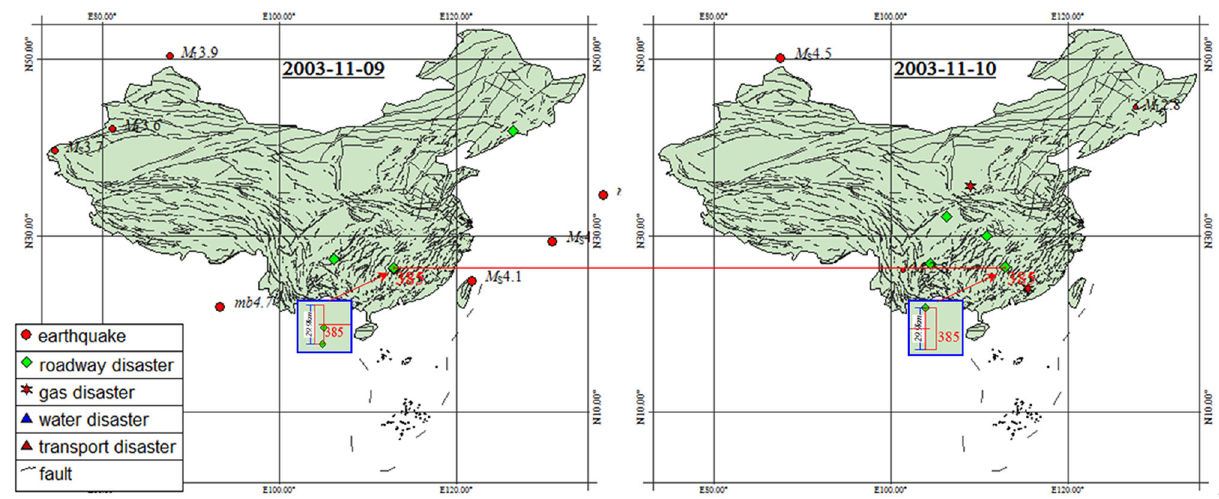
Fig. 1 Earthquakes and coal mine disasters occurring during the period from 9 to 10 November 2003 (faults are modified from a 1 : 2,500,000 Chinese Geological Map published by the Chinese Geological Survey, similarly